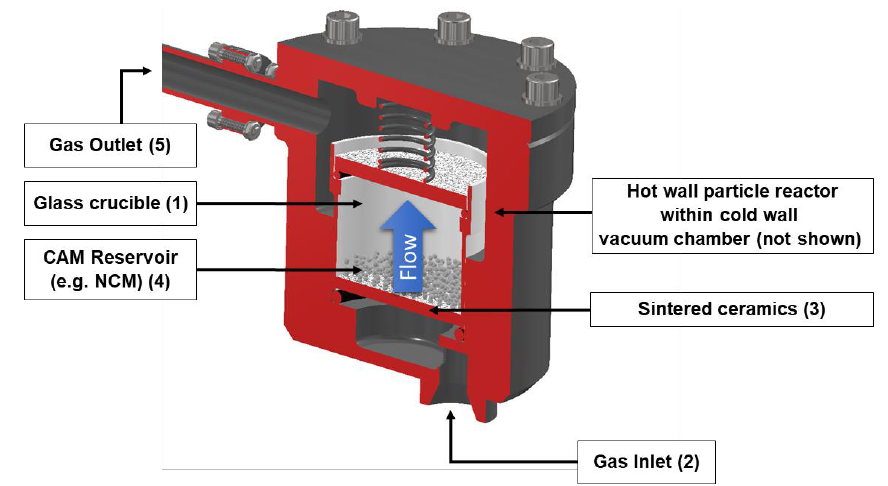
Figure 1. Diagram of the ALD Setup (a modified Beneq TFS